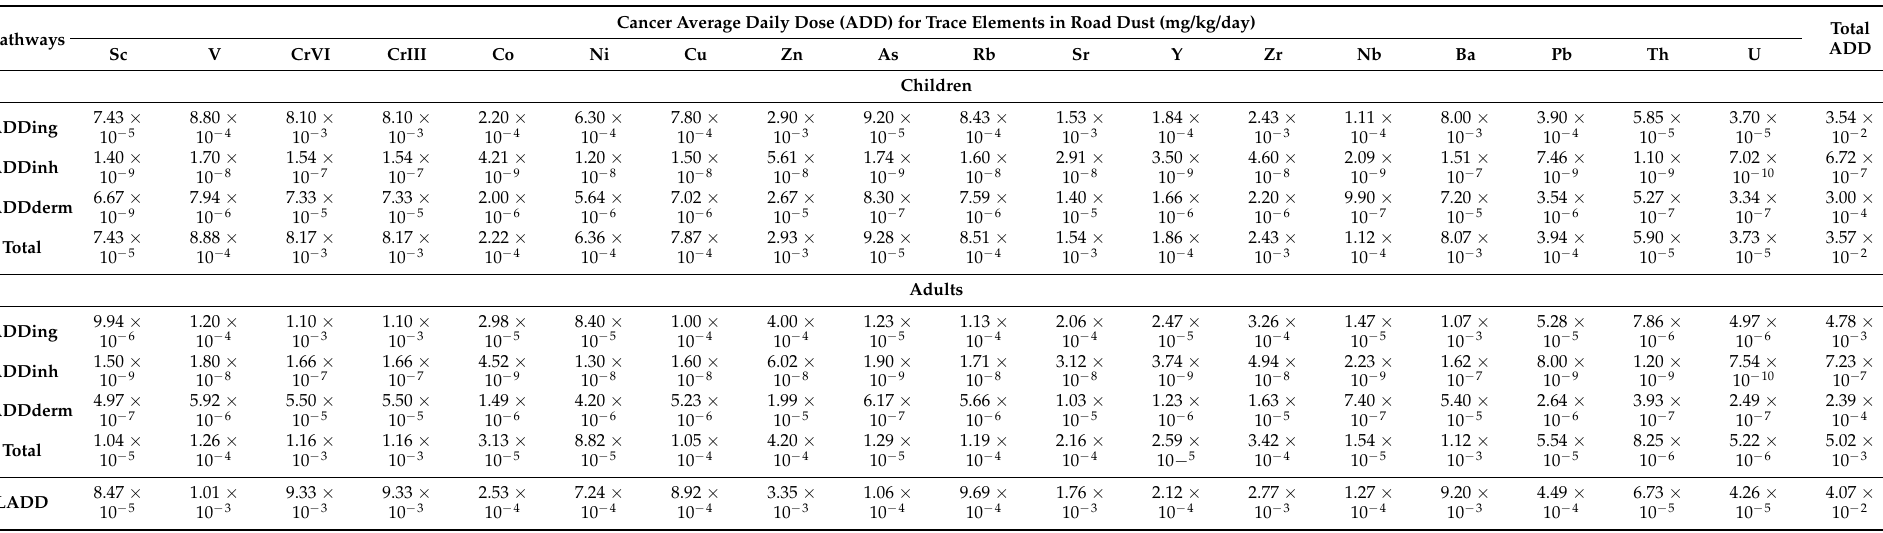
Table 13. Carcinogenic average daily dose (ADD) for trace elements in road dust via ingestion, inhalation, and dermal exposure pathways for children and